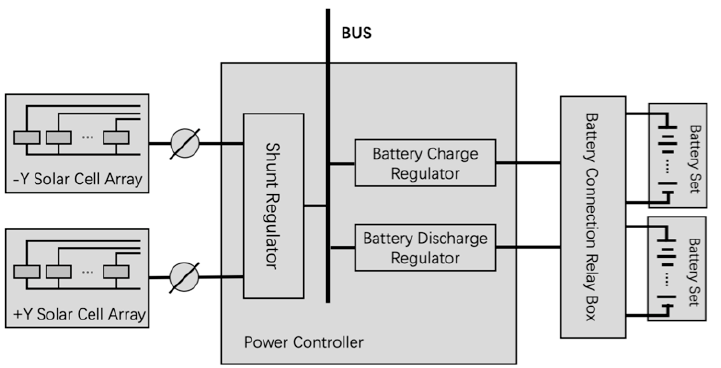
Figure 1. Diagram of the satellite power subsystem.